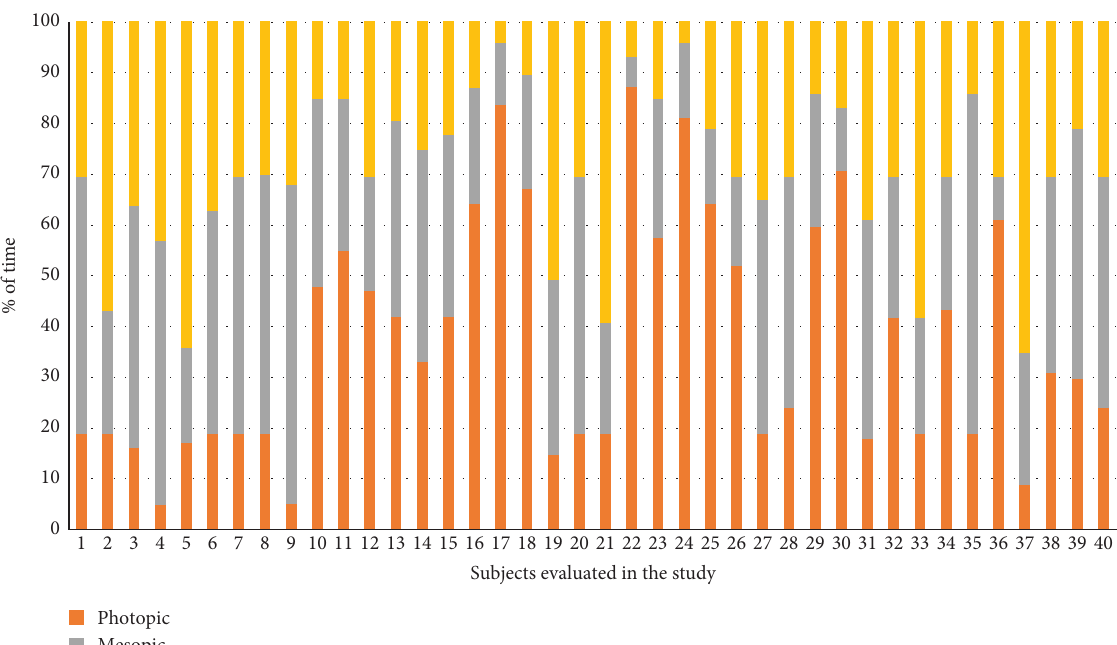
Figure 4: Distribution per patient of the time dedicated to activities performed under photopic, mesopic, and scotopic conditions measured in the evaluated sample.